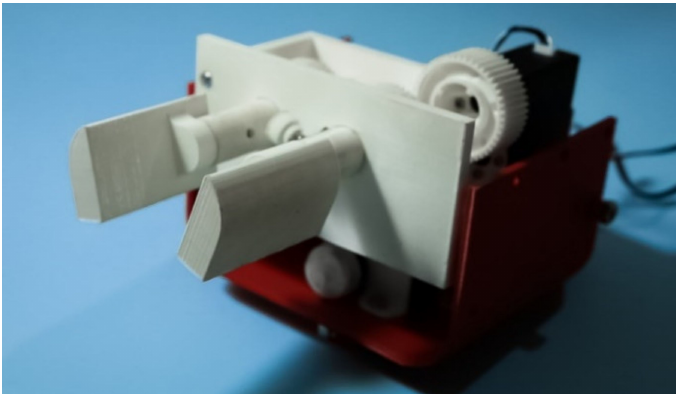
Figure 11. A photo of the final prototype at DIMEG, University of